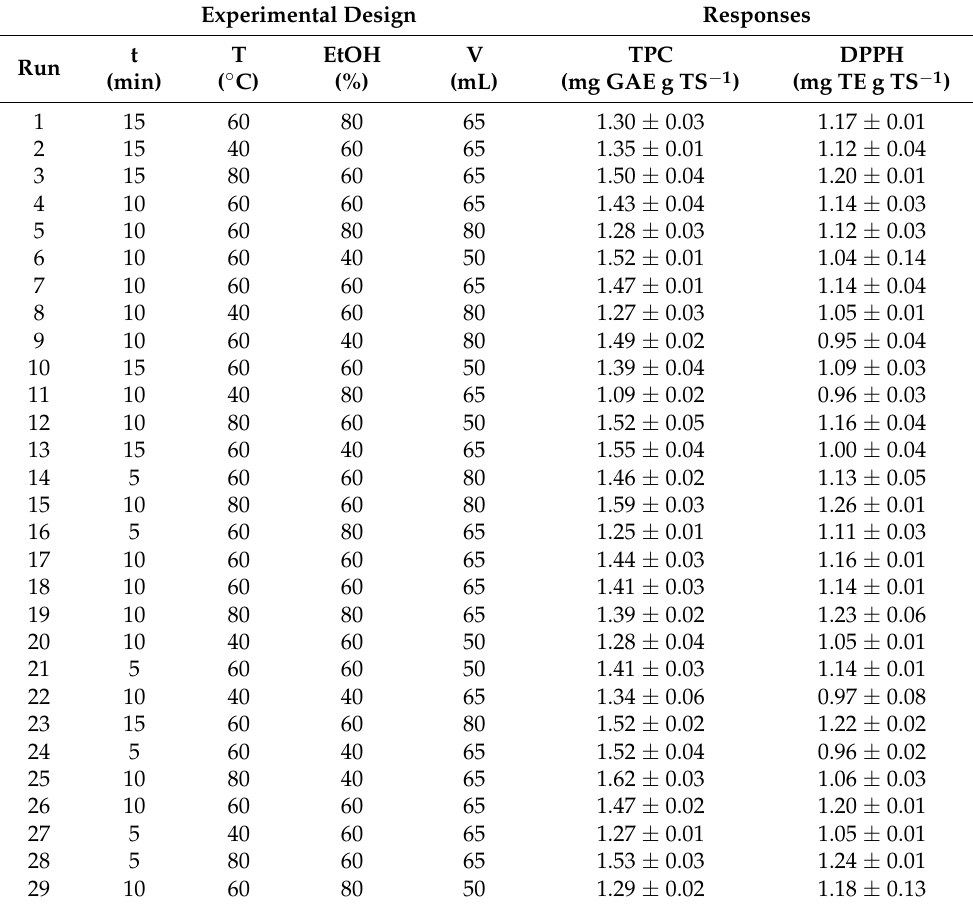
Table 1. Box–Behnken experimental design matrix and response values obtained from TS by MAE. Experimental